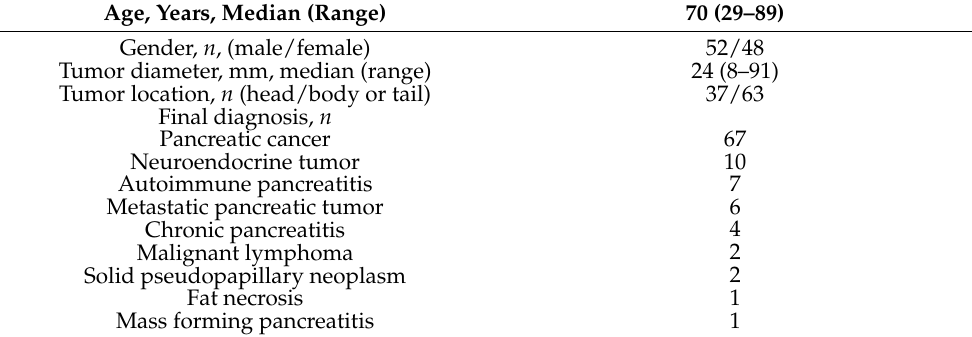
Table 2. Patient